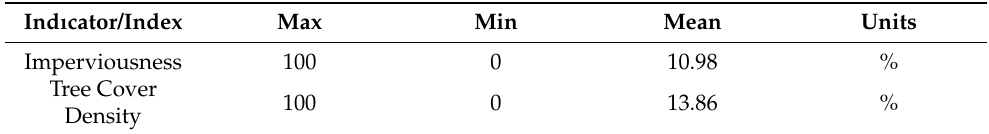
Table 2. Statistics of the Imperviousness and Tree Cover Density degree